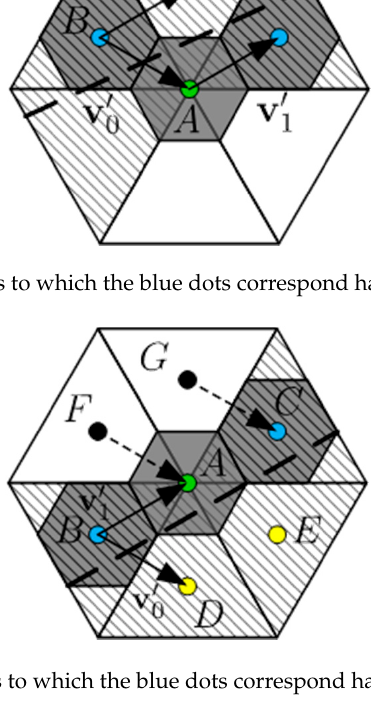
Figure 7. The triangles to which the blue dots correspond have different directions.